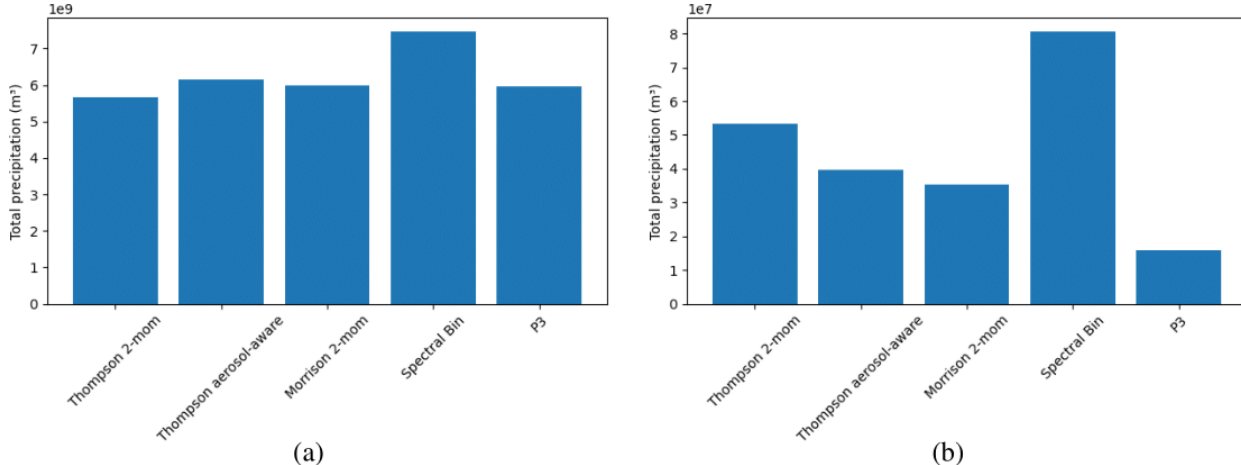
Figure 3. Total simulated precipitation over (a) 30d and (b) on 1 August 2020 over the Munich area.